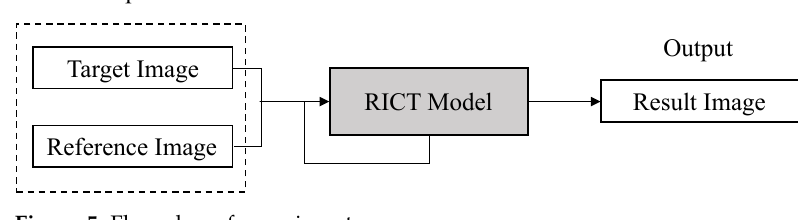
Figure 5. Flow char of